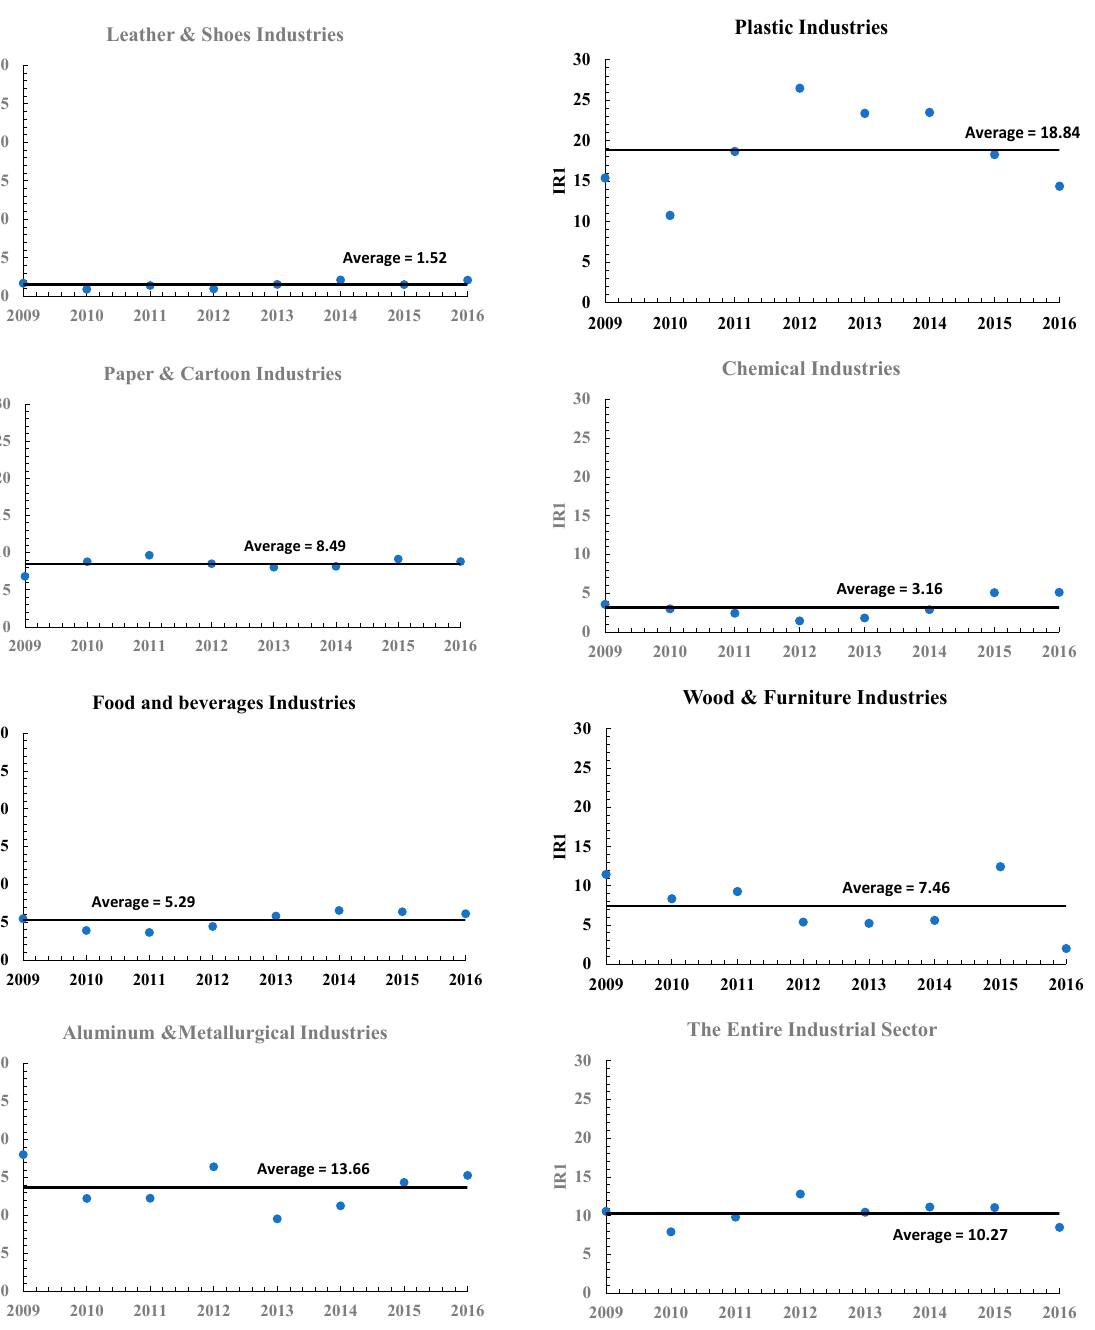
Figure 15. The Occupational Safety and Health Administration (OSHA) Incident Rate, based on injuries and illnesses (IR1) rates (per 100 full-time workers) for each targeted industrial sector during 2009–2016.